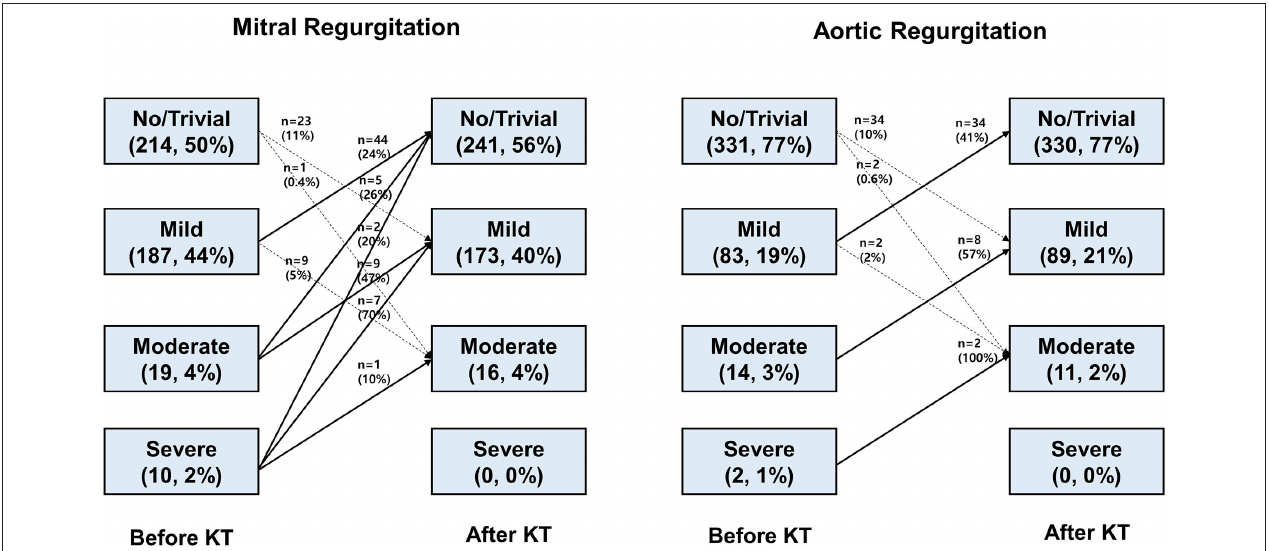
FIGURE 1 | Natural course of left-sided valvular regurgitation after kidney transplantation.